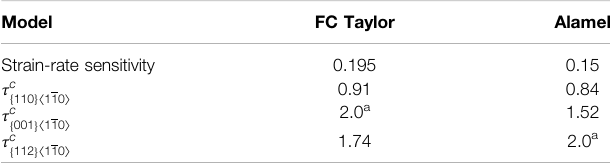
TABLE 3 | Case of AA6063, T (cid:1) 350 ° C. The best- fi t relative critical resolved shear stress (CSSR) for the three nonoctahedral slip systems considered in the texture optimization for FC Taylor and Alamel,